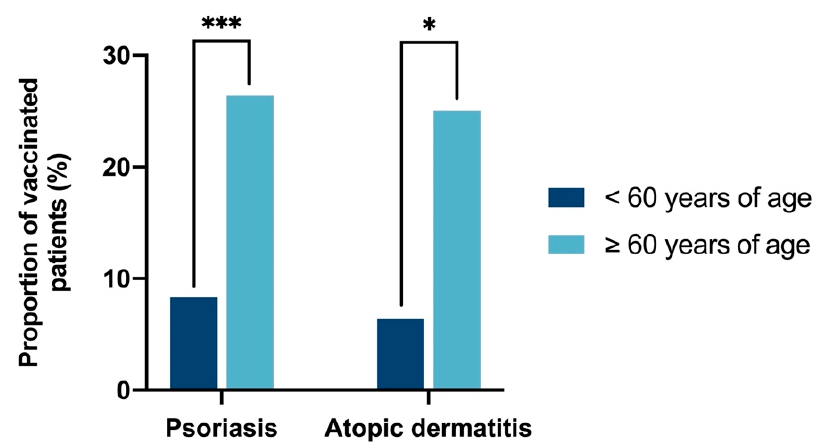
Figure 3. Pneumococcal vaccination according to age. Pneumococcal vaccination rate among the age groups < 60 years of age (PsO: n = 217 and AD: n = 78) and ≥ 60 years of age (PsO: n = 110 and AD n = 20). Patients with a pneumococcal vaccination at some point according to vaccination certificate were categorized as vaccinated. Patients ≥ 60 years of age showed a significantly higher vaccination rate than patients < 60 years of age (26.4% vs. 8.3%, p < 0.001 for PsO and 25.0% vs. 6.4%, p < 0.028 for AD). * p < 0.05; *** p <